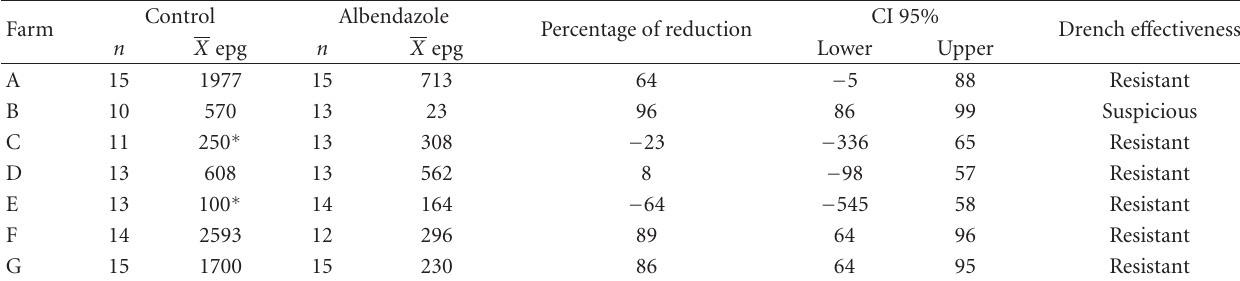
Table 1: Gastrointestinal nematode egg count percent reduction after treatment with albendazole in seven flocks from Costa Rica. Farm